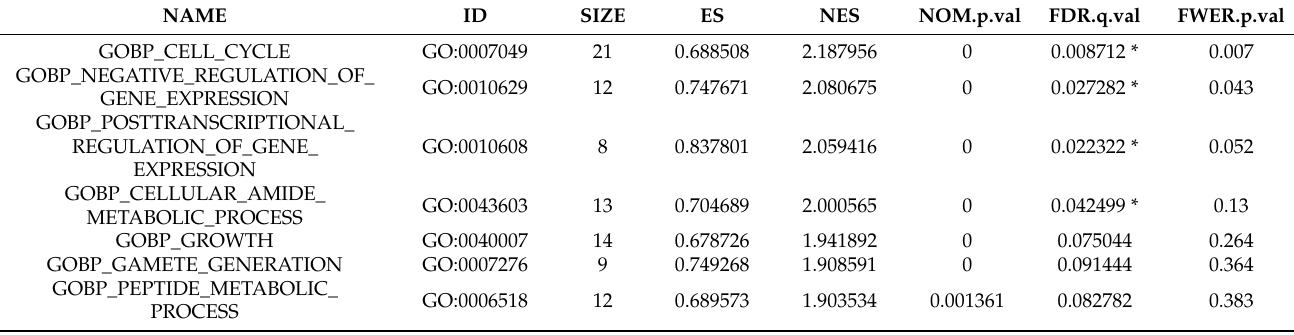
Table 4. Late (45 DPL peak) profile deregulated pathways in the Basal Ganglia.